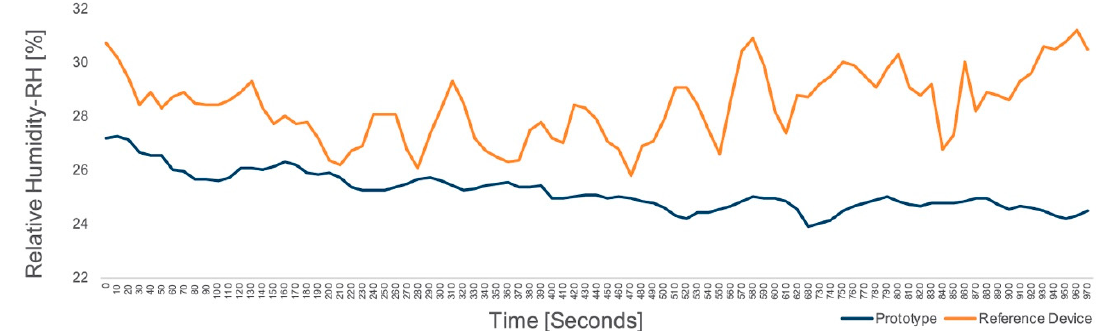
Figure 15. Validation graph for relative humidity.